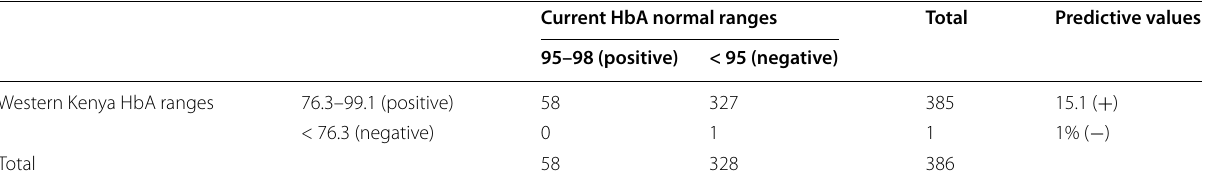
Table 3 Predictive validity of the currently HbA as a normal range in western Kenya